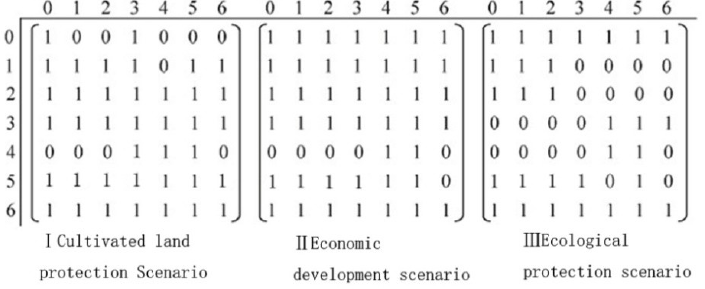
Figure 4. Matrix of land use conversion rules under three scenarios. Out matrix: (0) cultivated land, (1) garden land, (2) wood land, (3) other agricultural land, (4) construction land, (5) water, and (6) unused land. In matrix: (0) not transferable and (1) transferable.